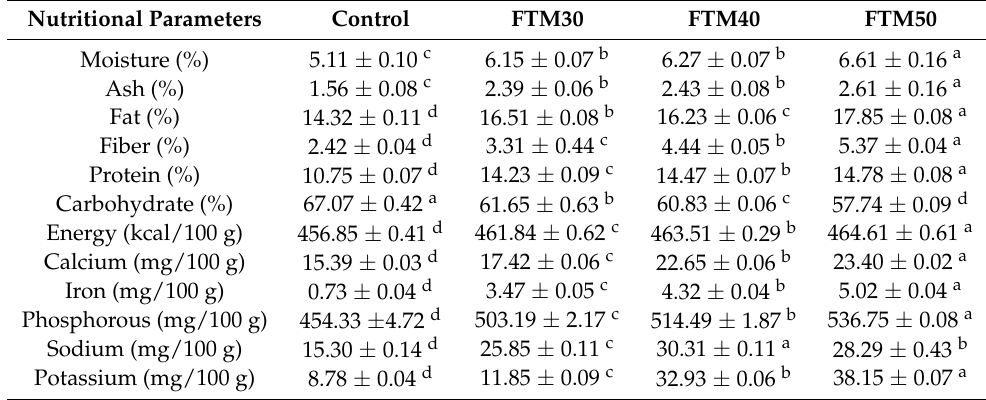
Table 1. Biochemical properties of the prepared noodles 1